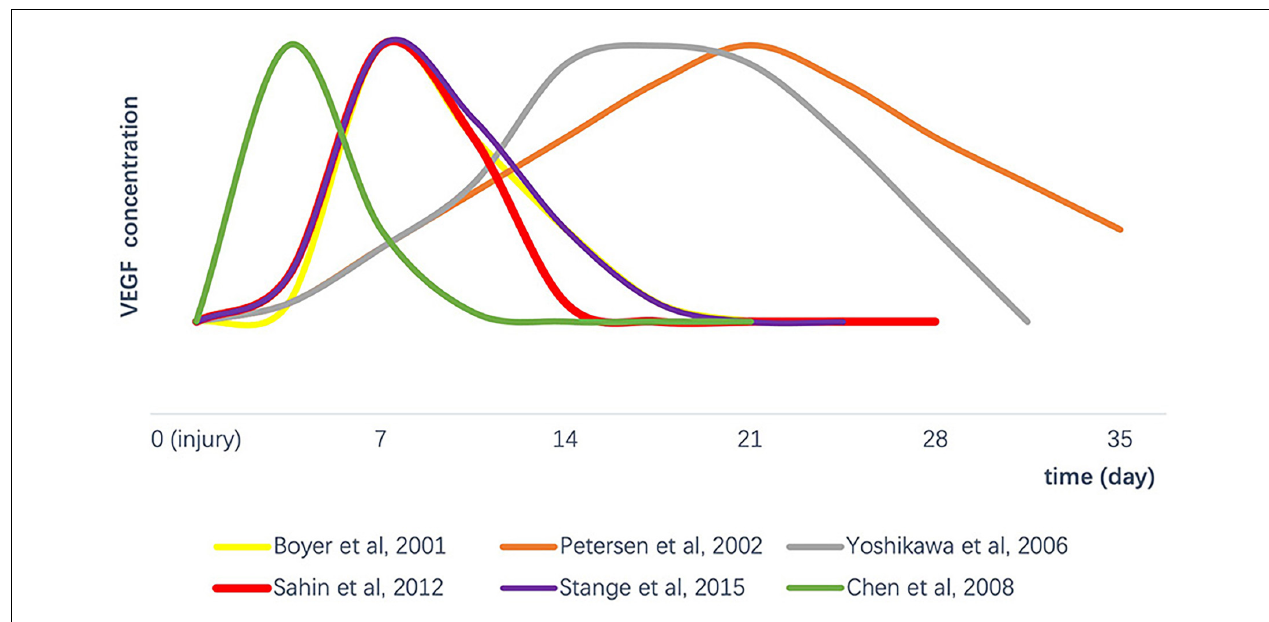
FIGURE 2 | The variation trend of gross VEGF concentration after tendon injury in various tendon injury models. VEGF, vascular endothelial growth